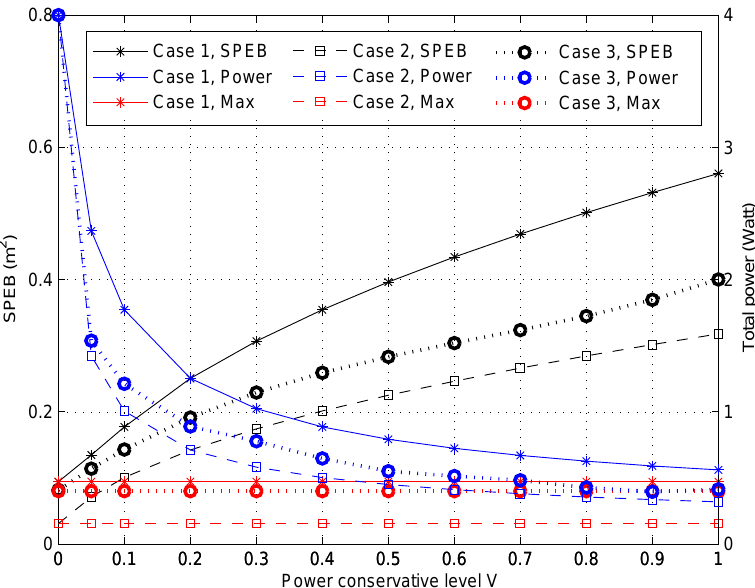
Figure 6. The SPEB of service area and total power consumption of anchor nodes with respect to different anchor-specific power conservation levels V